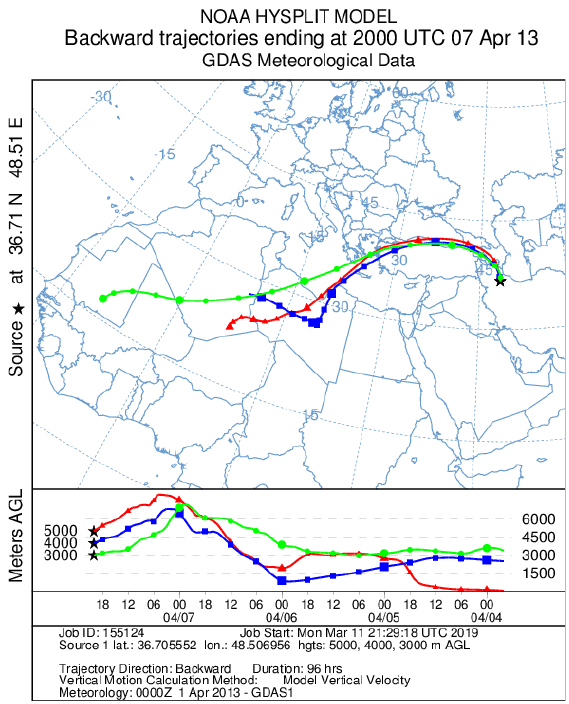
Figure 6 96 h HYSPLIT backward trajectories arriving at Zanjan on 20:00 UTC at 3, 4 and 5 km